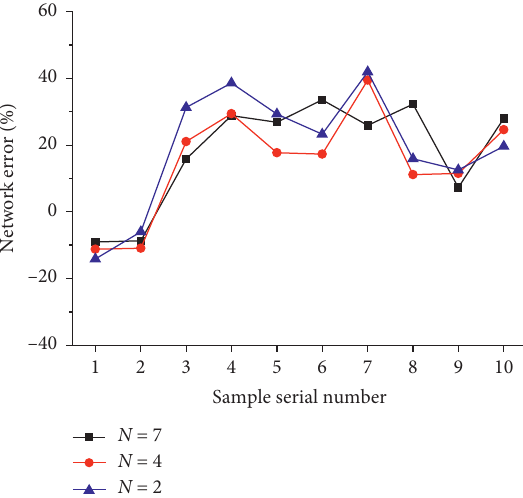
Figure 11: The prediction error curve of h neural network neurons was 2, 4, and 7, respectively.